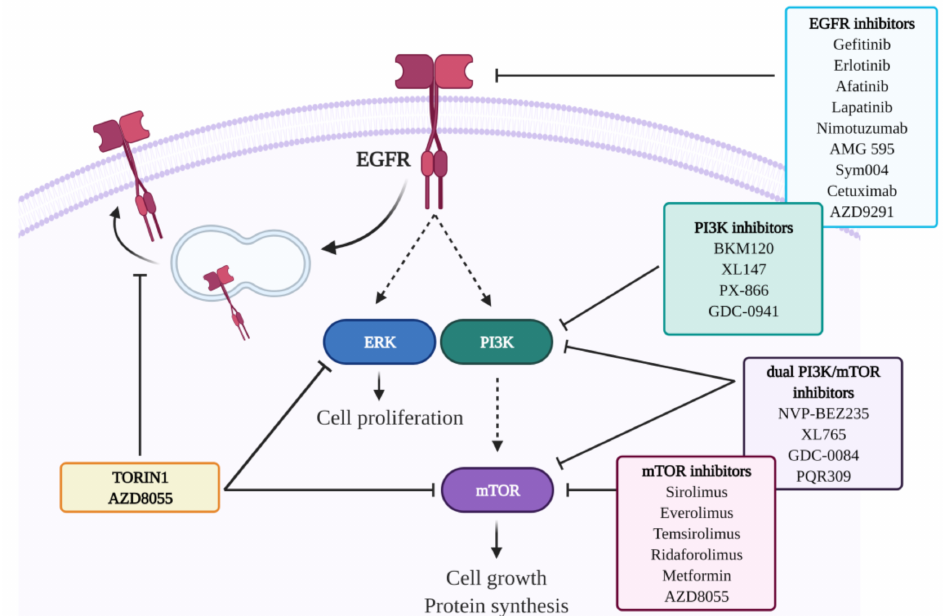
Figure 2. EGFR/PI3K/mTOR signaling pathway and inhibitory molecules used in preclinical